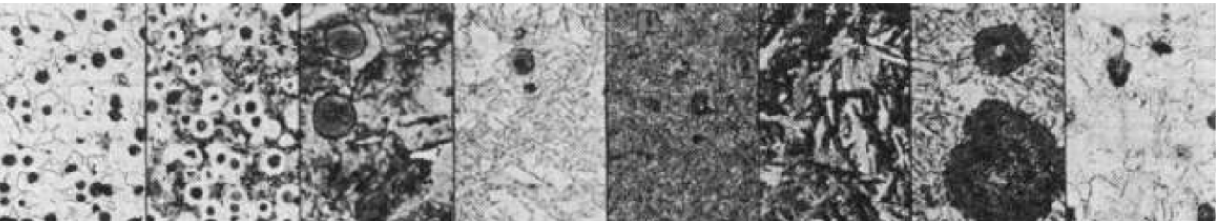
Figure 1: DCI microstructures (different magnifications). From left to right: ferritic, ferritic-pearlitic, pearlitic, martensitic, bainitic,